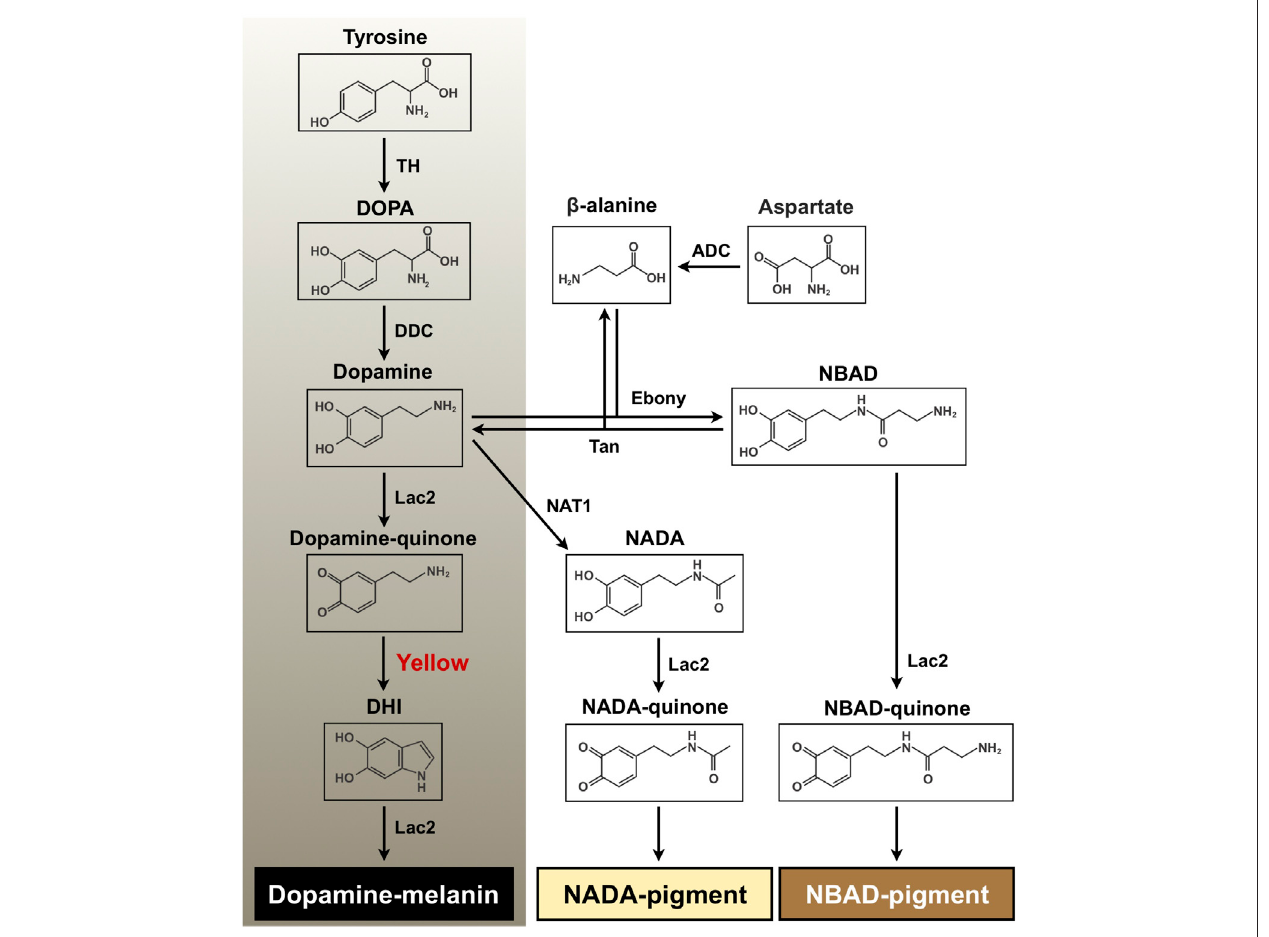
FIGURE 1 | Proposed melanin and quinoid pigment biosynthetic pathway. Tyrosine and dopamine are major precursors for synthesis of black melanin and N -acylquinoid-derived pigments. Yellow protein, which converts dopaminechrome to dihydroxyindole (DHI) and accelerates melanin biosynthesis, is highlighted in red. DOPA, 3,4-dihydroxyphenylalanine; Dopamine, 4-(2-aminoethyl)benzene-1,2-diol; DHI, 5, 6-dihydroxyindole; NBAD, N - β -alanyldopamine; NADA, N -acetyldopamine; TH, tyrosine hydroxylase; DDC, DOPA decarboxylase; Lac2, laccase 2; ADC, aspartate 1-decarboxylase; Ebony, N - β -alanyldopamine synthase; Tan, NBAD hydrolase; NAT1, arylalkylamine N -acetyltransferase 1.